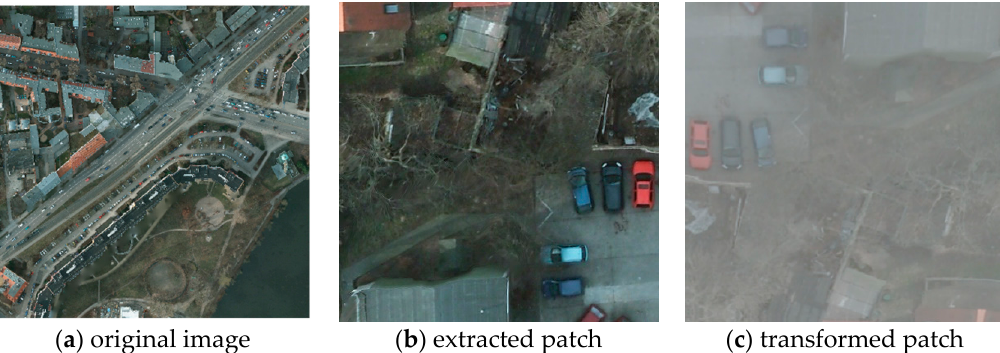
Figure 9. ( a ) is the original image with 6000 × 6000 pixels. ( b ) is the extracted patch with 512 × 512 pixels from the original input image and ( c ) is the transformed one with flip, brightness, and contrast change operations, etc.